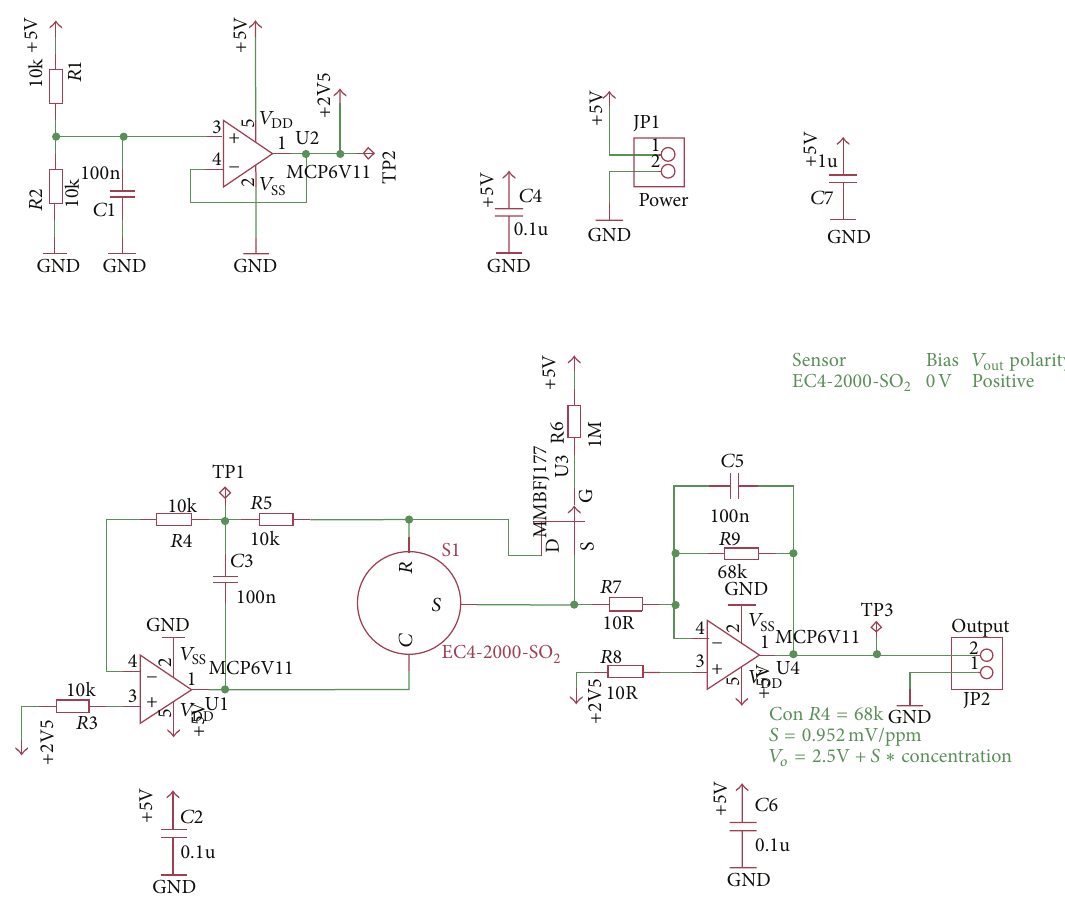
Figure 7: Circuit designed for SO 2 signal conditioning.